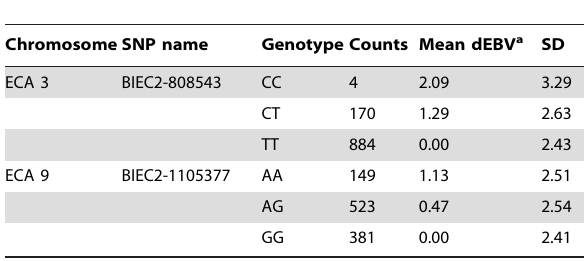
Table 3. Effect of different QTL genotypes on the dEBV height at withers.